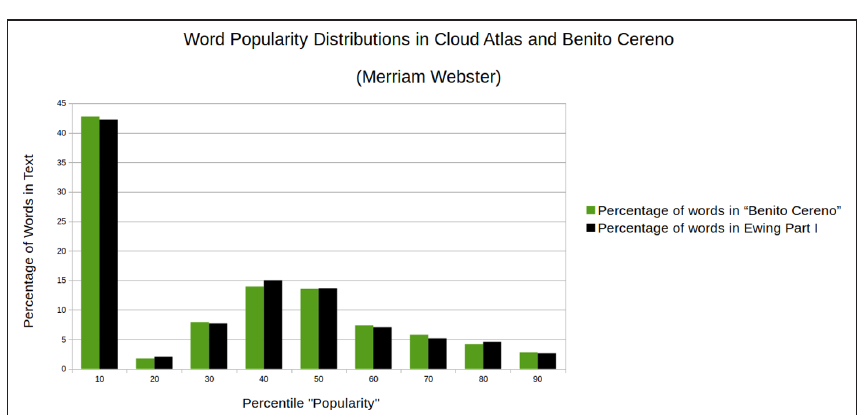
Figure 2: Word “popularities” in The Pacific Journal of Adam Ewing Part I and Benito Cereno